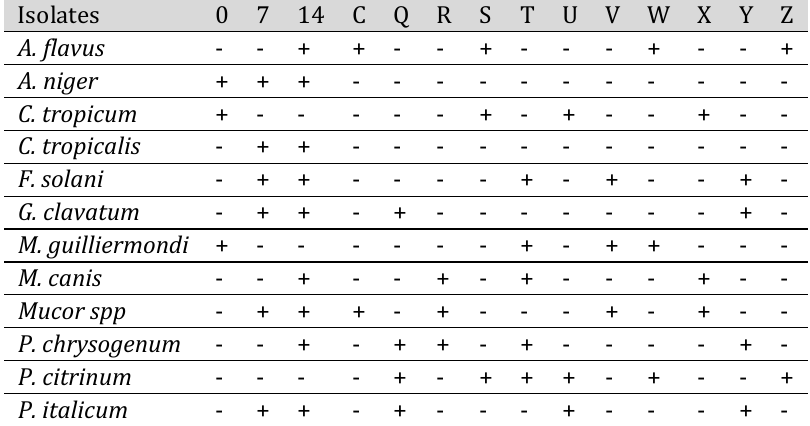
(Table 8). The occurrence of microorganisms in the treated raw palm oil on each day of the analysis is shown in Table 9. Table 8. Occurrence of fungal isolates in the analyzed palm fruits and palm oil samples.